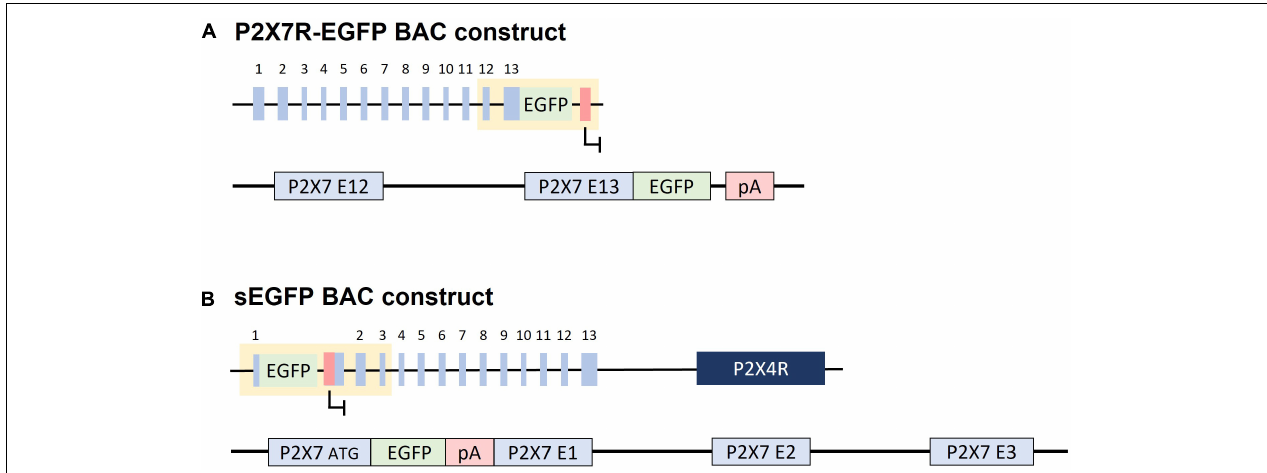
FIGURE 2 | Constructs used for generation of BAC transgenic reporter mice. (A) P2X7R -EGFP: An EGFP cassette was inserted downstream of the P2X7R coding sequence in exon 13 creating a P2X7R -EGFP fusion transcript. (B) sEGFP: An EGFP cassette was inserted at the ATG of the P2X7R in exon 1, theoretically blocking the transcription of the remainder of the gene through its poly A signal. The P2rx4 gene is present 16 kb downstream of the P2X7R construct. “pA/red box”: Polyadenylation signal.